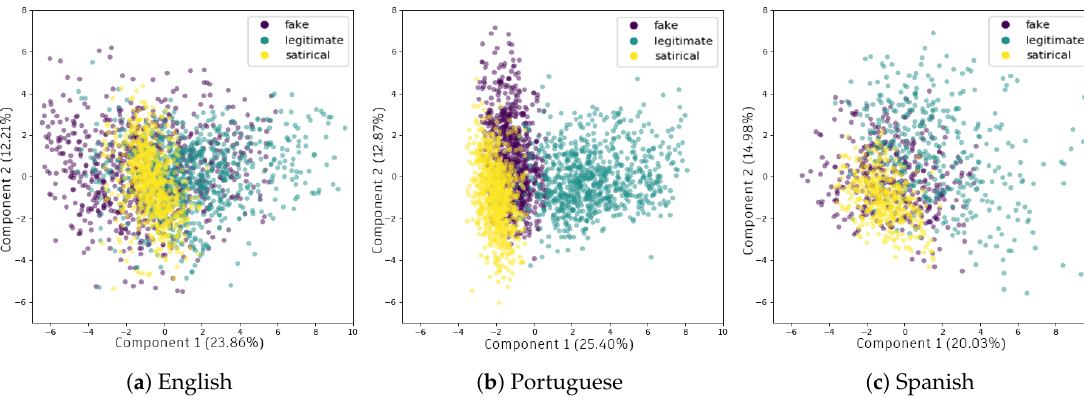
Figure 2. Two-dimensional plot of Principal Component Analysis (PCA) of three datasets showing the distribution of classes on a lower dimensional vector space.